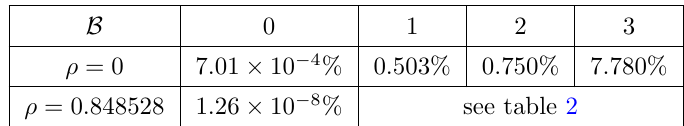
Table 1 . Comparison to equilibrium data: deviation (in percent) between our late time thermo- dynamic data (i.e. pressures P L;T ) and the equilibrium solutions, i.e. the Schwarzschild, Reissner- Nordstr(cid:127)om, and purely magnetic black brane